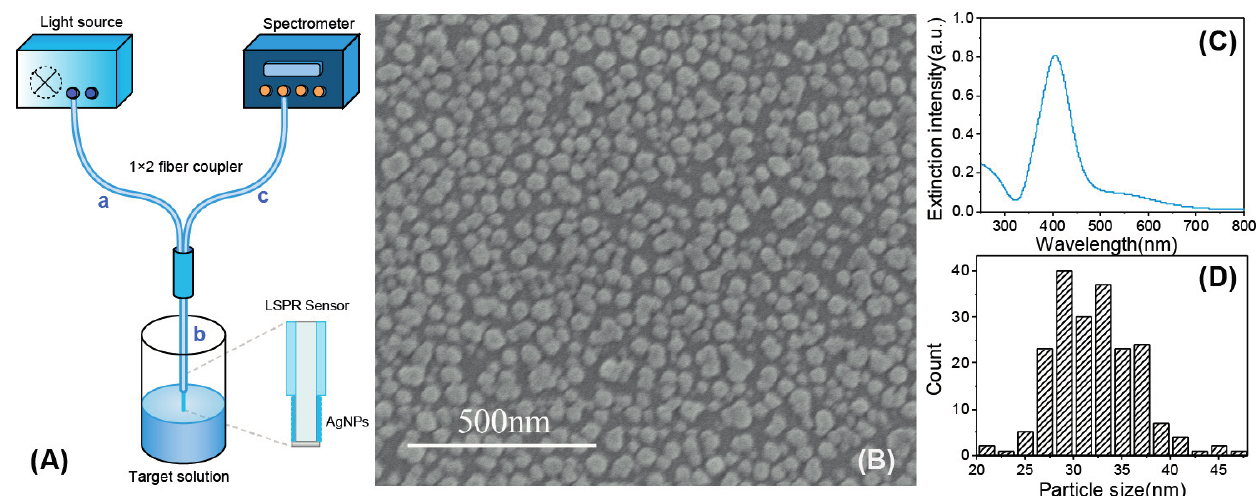
Figure 2. ( A ) Schematic of the experimental set-up used in this study; ( B ) An SEM image of AgNPs after being immobilized on optical fiber; ( C ) Absorption spectra of AgNPs solutions; ( D ) Histogram showing the corresponding particle size distribution of